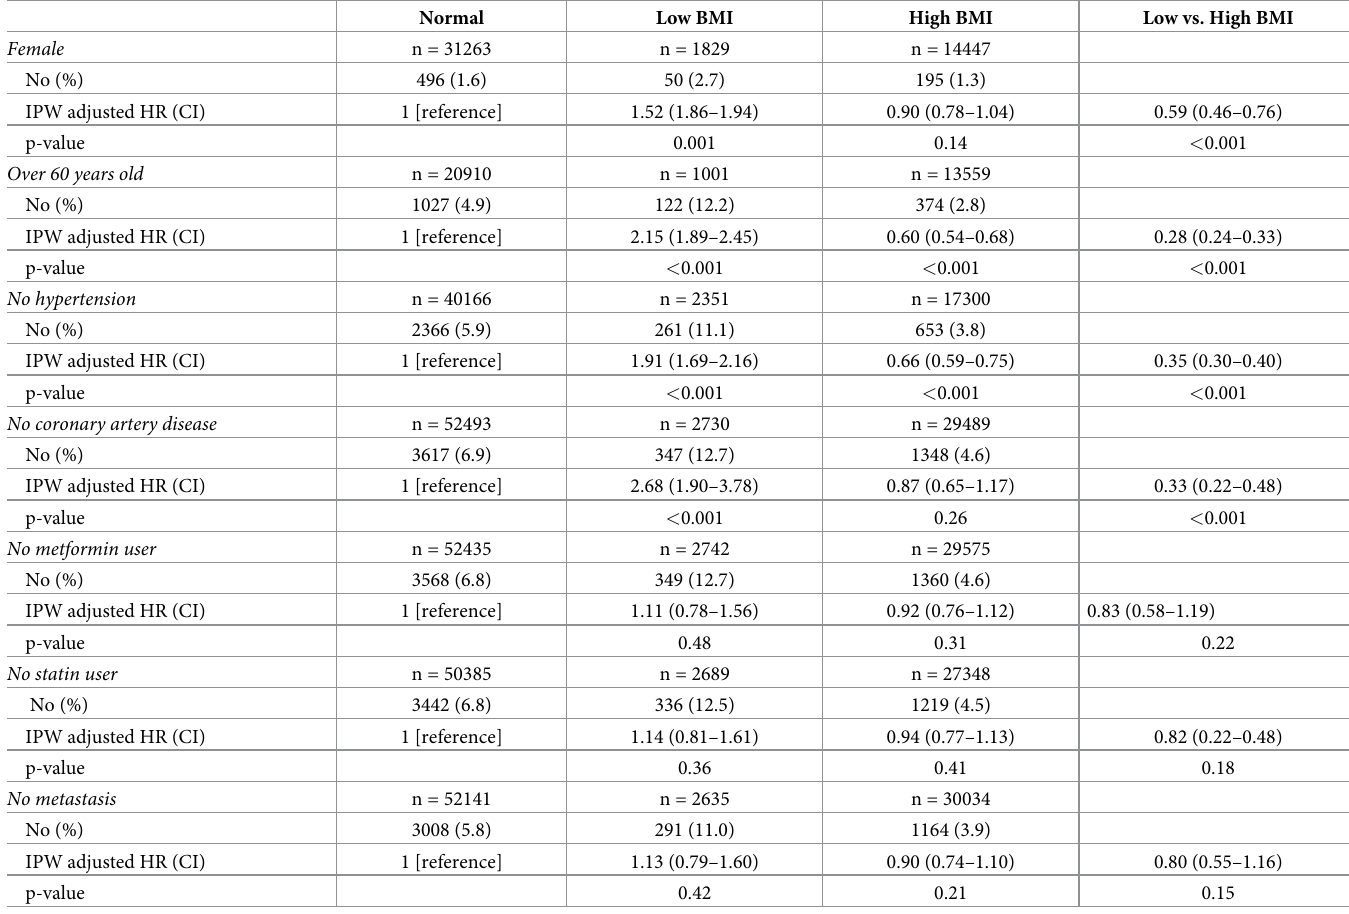
Table 4. Association between three-year mortality and preoperative body mass index in female and patients aged over 60 years old.